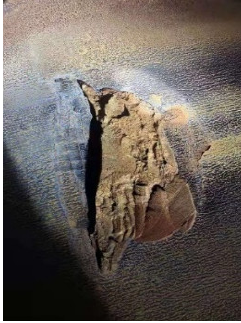
Figure 3. Back-up roll surface spalling.